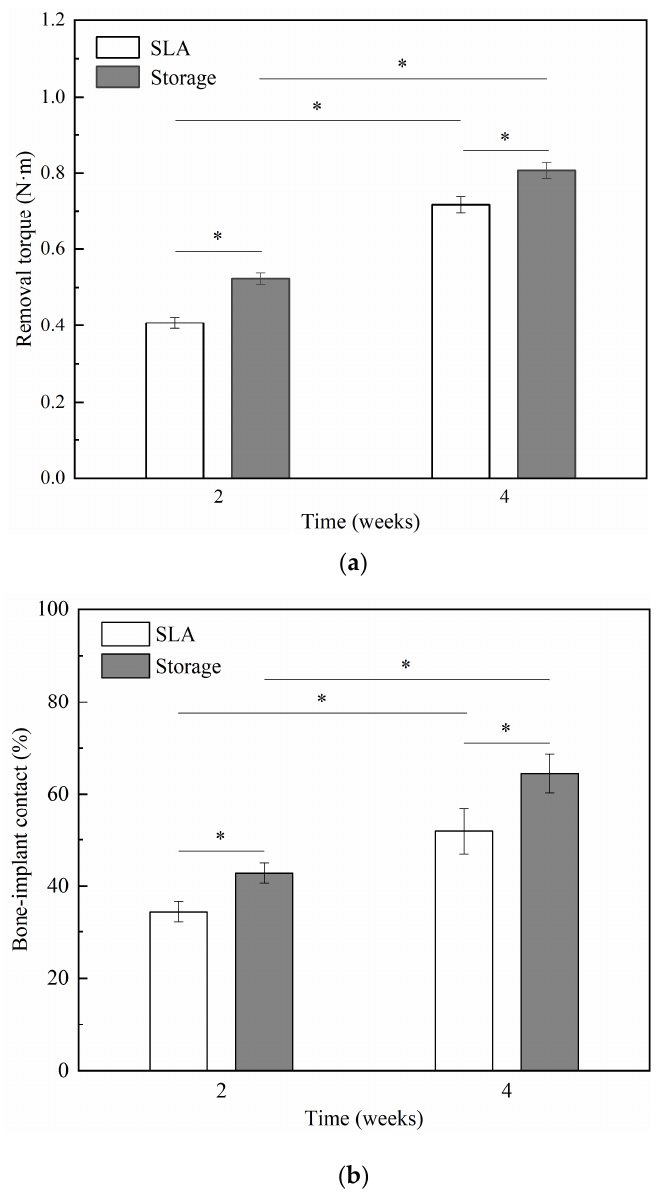
Figure 7. ( a ) Removal torque value results (x ± s , n = 3, * indicates P < 0.05 among groups); ( b ) Bone-implant contact results (x ± s , n = 4, * indicates P < 0.05 among